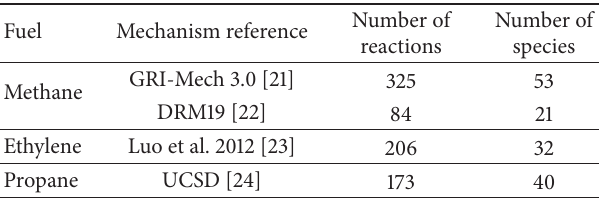
Table 2: Reaction mechanisms.